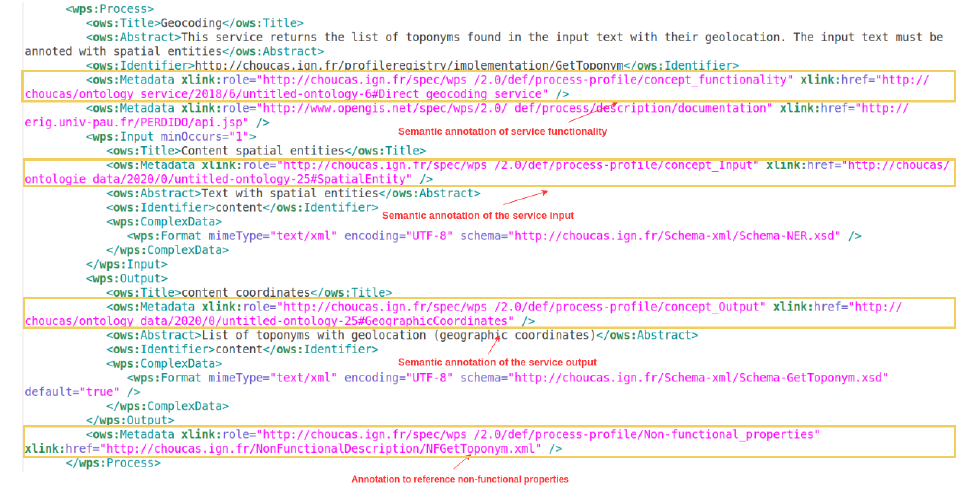
Figure 5. How SAWPS allows us to encode the semantic annotation.